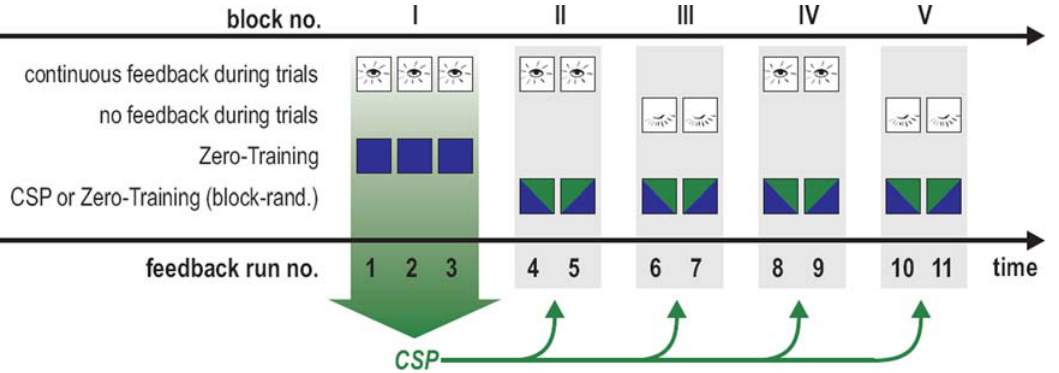
Figure 3. Overview of the 11 runs and the two methods used for calculating feedback. In block I, continuous visual feedback was given by a classifier that had been pre-computed with the Zero-Training method, see Section ‘‘Construction of Classifiers’’. Blocks II to V each contained one run with Zero-Training feedback and one run with ordinary CSP feedback. The order of the two feedback methods was chosen randomly and remained unknown to the subject. The use of continuous visual feedback and no continuous visual feedback alternated regularly between blocks II to V. Table 1 for the imagery used by each subject), in order to hit the target with the cursor. Depending on the block (see Figure 3), the cursor was either visible during this cursor movement phase (continuous visual feedback) or a blank screen was presented for 3.5 seconds (no continuous visual feedback).